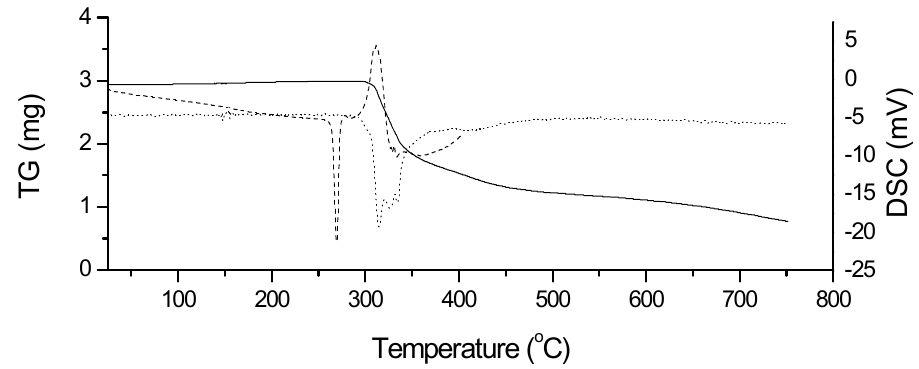
Figure 3. Dynamic TG ( _____ ), DTG ( ...... ) and DSC (----) curves for HCTZ, under